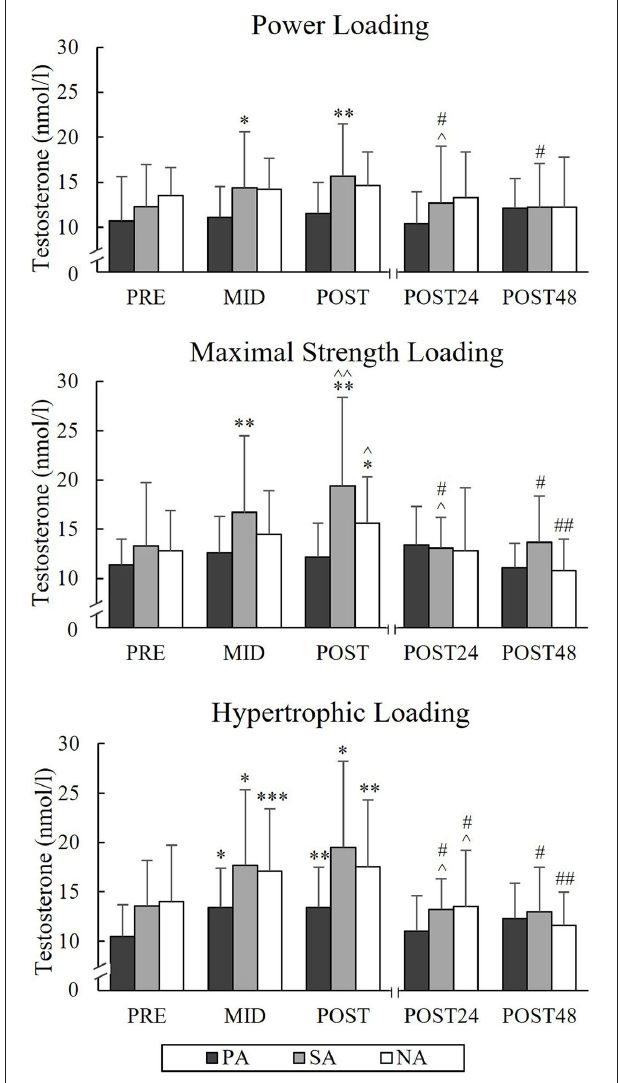
FIGURE 9 | Serum testosterone concentrations of Pre, Mid, Post, Post24, and Post48 during three resistance exercise loadings in power (PA), strength (SA), and non-athletes (NA). * p < 0.05, ** p < 0.01, *** p < 0.001 refer to within-group significances compared to Pre. ∧ p < 0.05, ∧∧ p < 0.01 refer to within-group significances compared to the previous time point. # p < 0.05, ## p < 0.01 refer to within-group significances compared to Post during